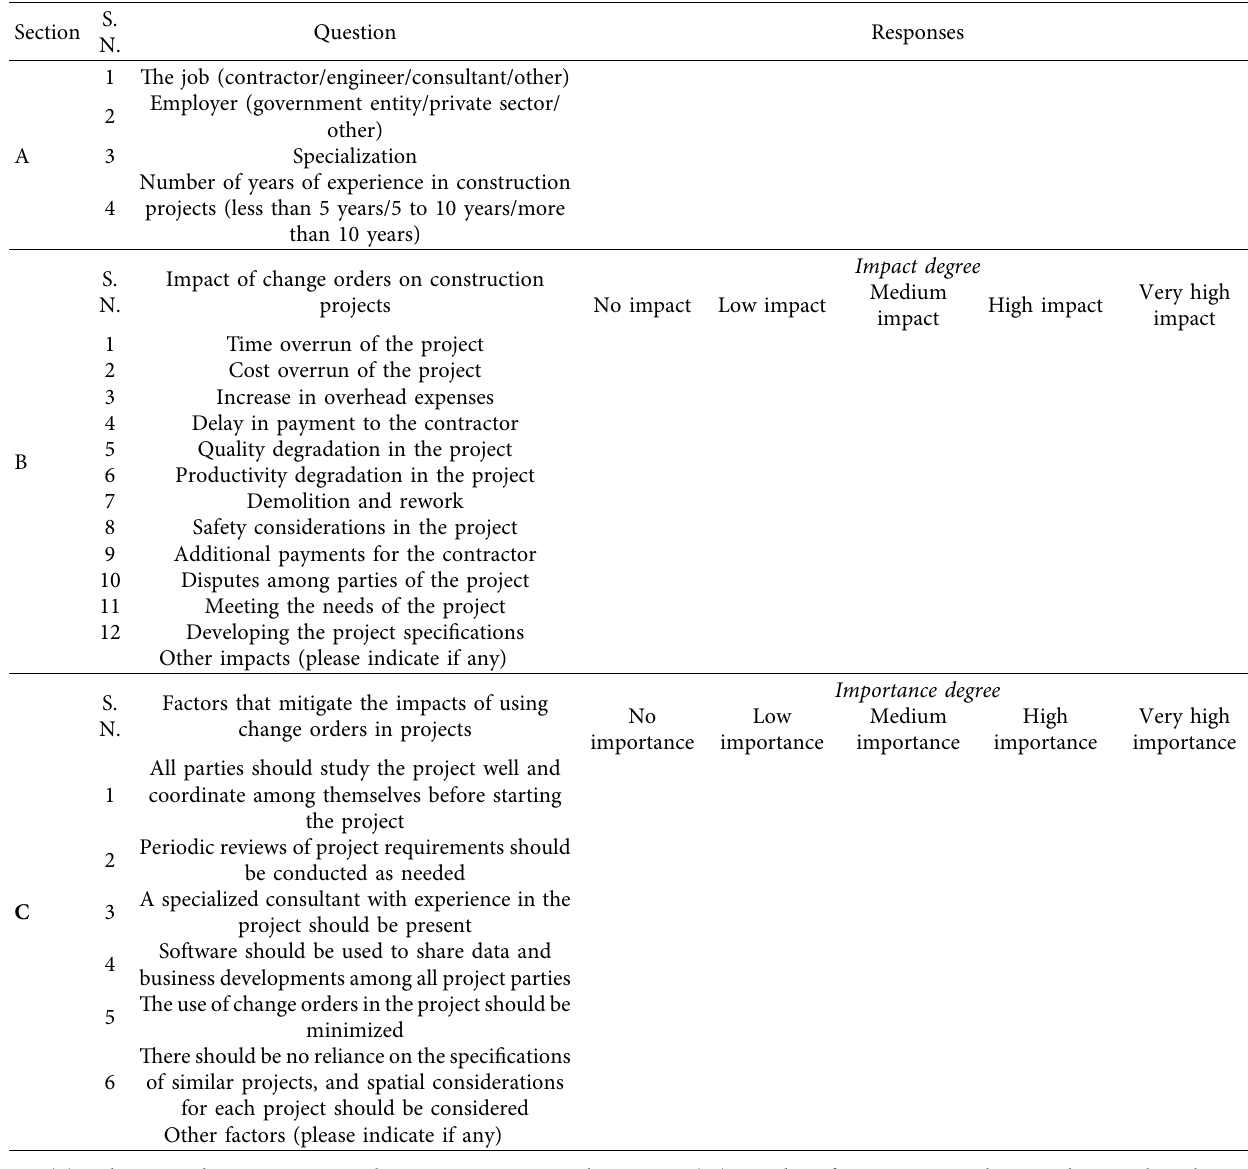
Table 5: )e final form of the questionnaire.